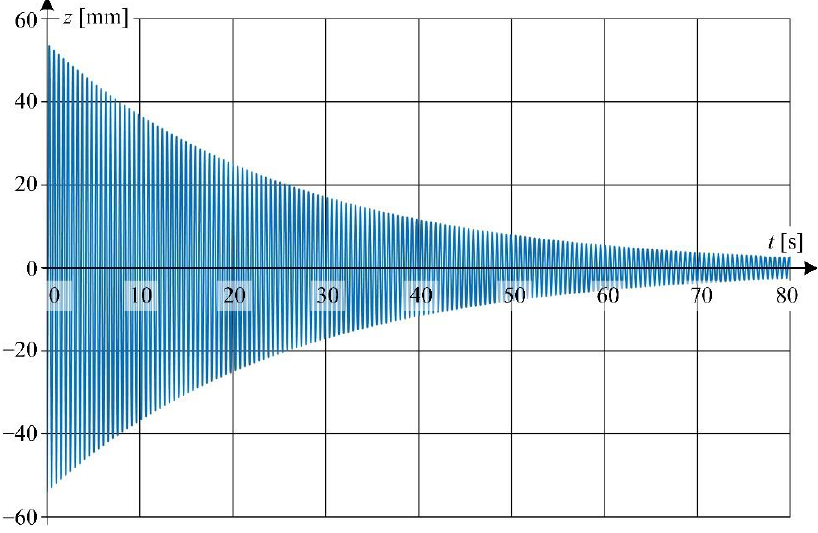
Figure 17. Displacement waveforms of simulation results at linear damping coefficient.